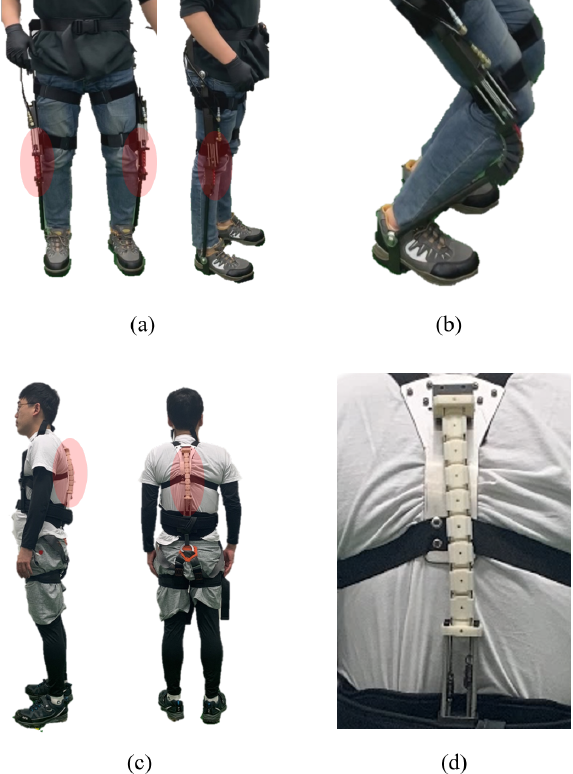
Figure 9. The two SJLM applications: ( a ) a lower-limb assistive device under high-stiffness adjustment and ( b ) bent with elasticity under low-stiffness adjustment; ( c , d ) a spine assistive device designed as a harness type to support a thoracic/lumbar spine.